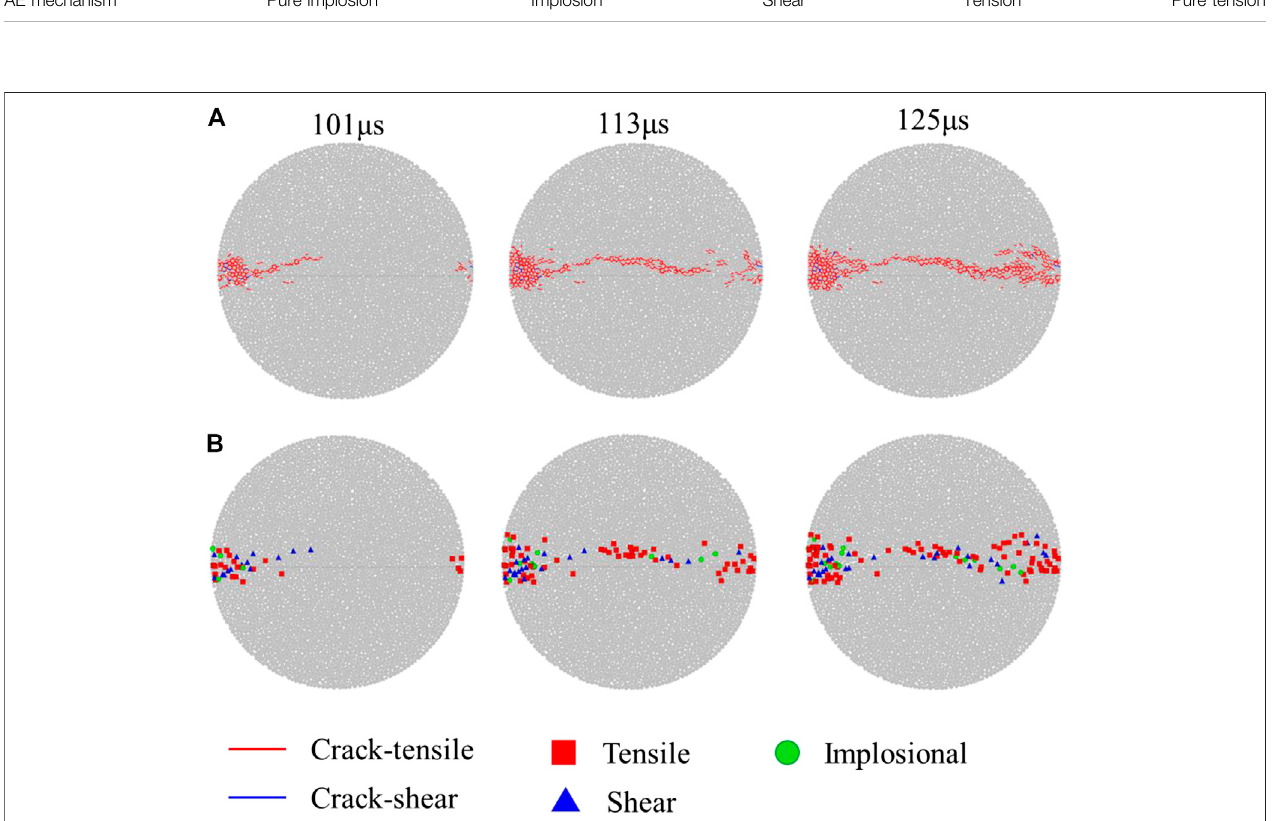
FIGURE 10 | Microscopic mechanism of the axial crack generation. (A) is the results of DFN obtained by PFC. (B) is the results of AE source mechanism obtained based on the moment tensor.